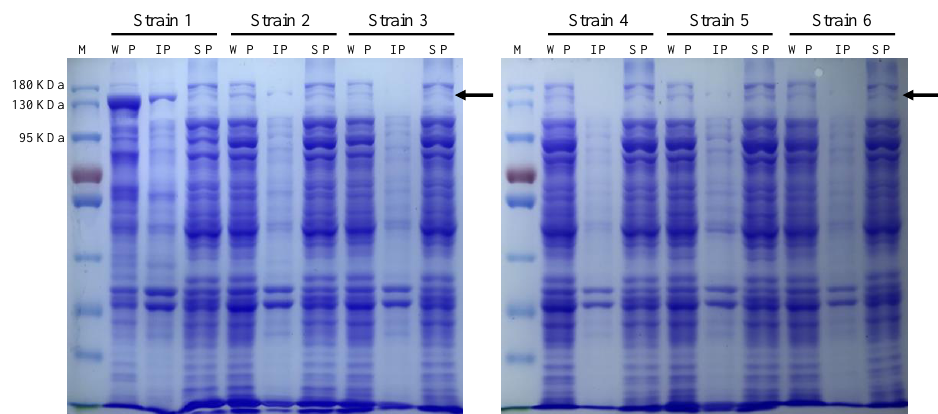
Figure A3. The expression level and solubility of the chimeric ATR2 Δ2– 74 - Lau C4H Δ2– 28 fusion protein in the p -coumaric acid producers. Strain 1, Ec/ Lau C4H; Strain 2, Ec/ Lau C4H- Ath PAL; Strain 3, Ec/ Lau C4H- Ath PAL-sRNA; Strain 4, Ec/ Lau C4H- Ath PAL-PntAB; Strain 5, Ec/ Lau C4H- Ath PAL-anti(sthA); Strain 6, Ec/ Lau C4H- Ath PAL-PntAB-anti(sthA). KDa, kilodalton; M, protein marker; WP, whole-cell proteins; IP, insoluble proteins; SP, soluble proteins. The arrows indicated the chimeric ATR2 Δ2– 74 - Lau C4H Δ2– 28 fusion protein.